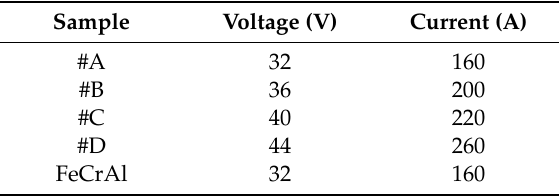
Figure 1. LSARC arc spraying equipment: ( a ) Wire feed, ( b ) spray gun, and ( c ) spray controller and power supply. Table 2. Process parameters.